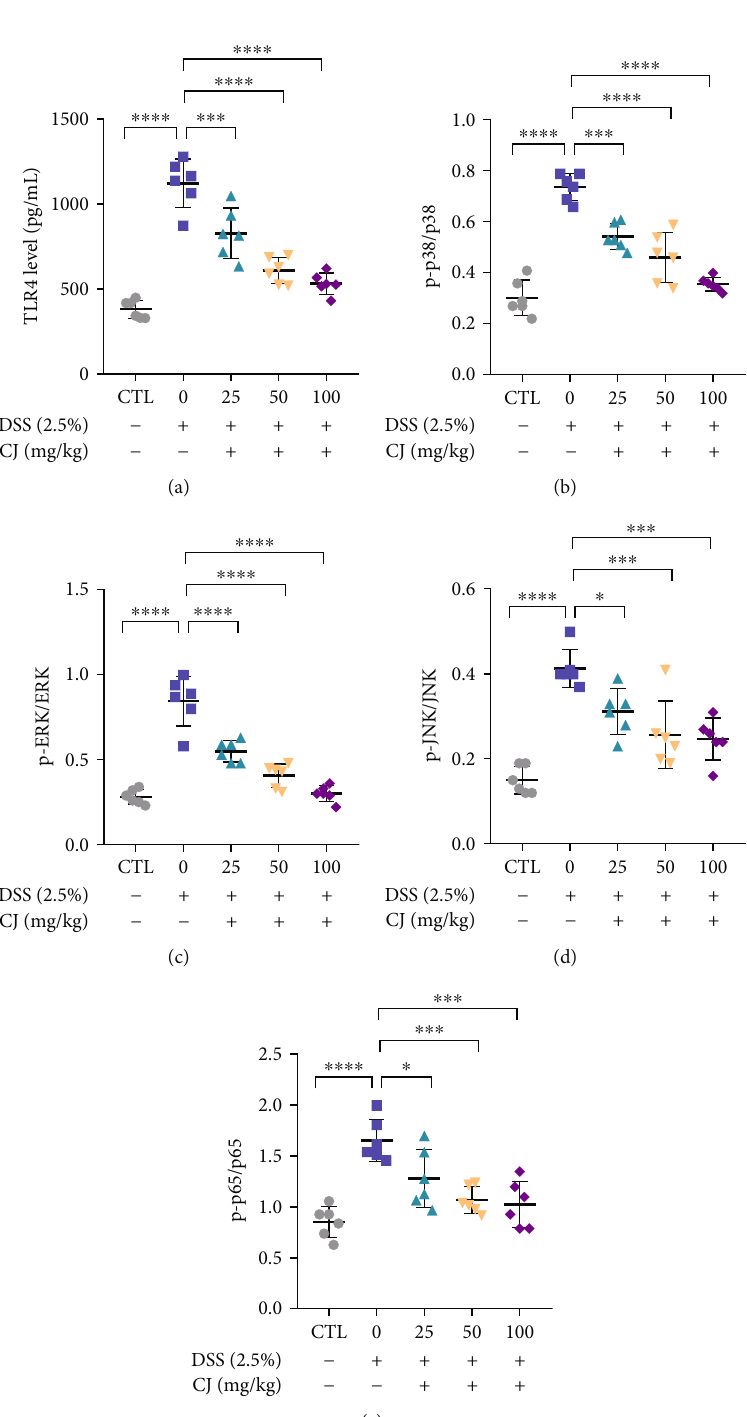
Figure 6: CJ regulates the TLR4/MAPK/NF- κ B pathway in DSS-induced UC mice. (a) TLR4 protein expression in colon tissues detected by ELISA. (b – e) The ratios of phosphorylated/total p38 (b), ERK (c), JNK (d), and NF- κ B p65 (e) proteins of p38 in colon tissues by ELISA. n = 6 . ∗ p < 0 : 05 ; ∗∗ p < 0 : 01 ; ∗∗∗ p < 0 : 001 ; ∗∗∗∗ p < 0 : 0001